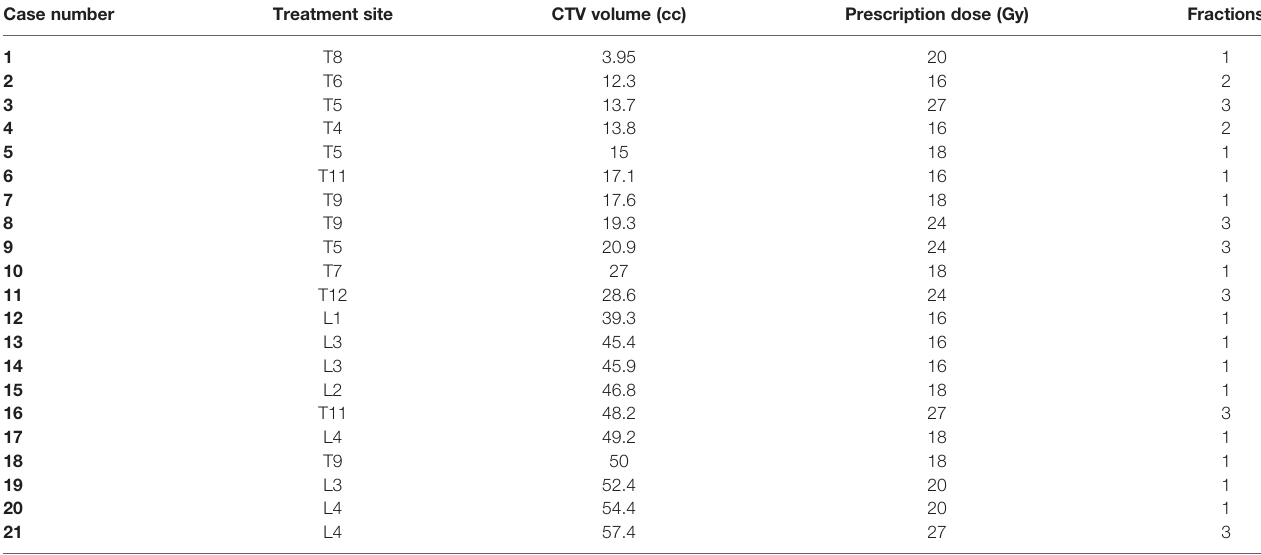
TABLE 1 | Summary of all cases (21 lesions) sorted by clinically used CTV